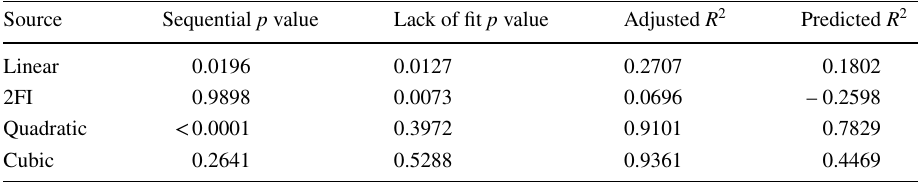
Table 3 Statistical adequacy evaluation of